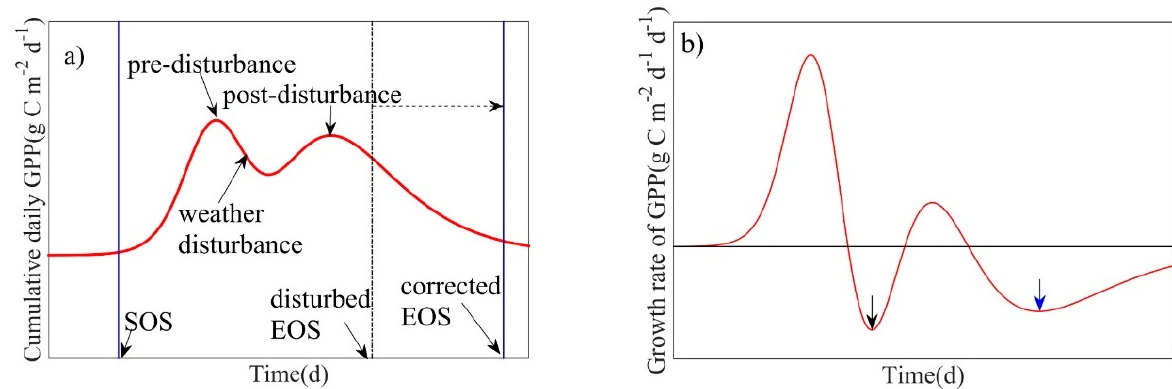
Figure 3. Schematic diagram of the influence of weather events on phenological process characteristics at ecosystem-scale: ( a ) A ( t ) is shown as the fitted red curve, the black dotted line is the default end of growing season (EOS) output of the phenology model using the first maximum GPP decline rate caused by short-term summer drought as the slope of A SL ( t ) to predict EOS, the solid blue line on the right is the corrected EOS using the second maximum GPP decline rate as the slope of A SL ( t ) to predict EOS; ( b ) k ( t ) is shown as the fitted red curve, the black arrow points to the first maximum GPP decline rate caused by weather disturbance, the blue arrow points to the second maximum GPP decline rate after weather disturbance in autumn.